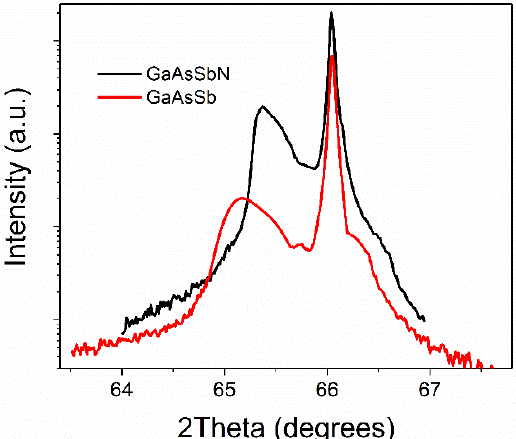
Figure 1. High-resolution X-ray diffraction (004) curves of GaAsSbN and GaAsSb layers.